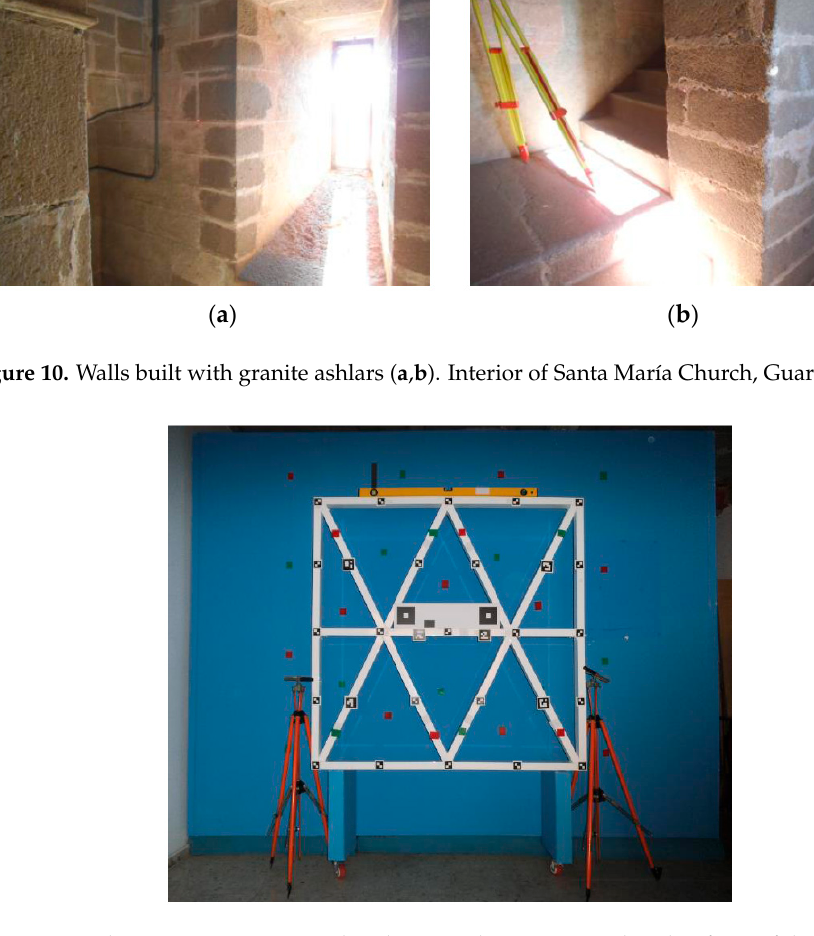
Figure 11. Aluminum structure used in the second experiment placed in front of the blue wall.